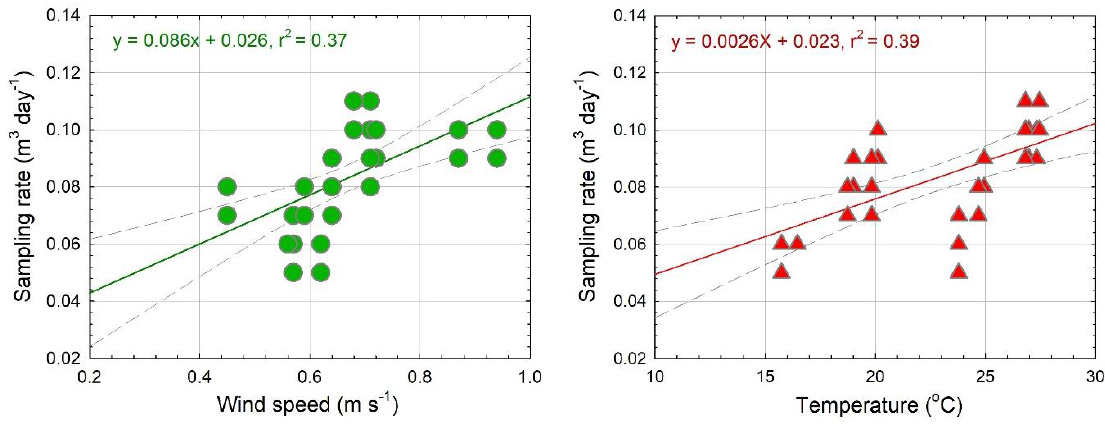
Figure 8. E ff ects of wind speed ( left ) and temperature ( right ) on the experimental Figure 8. Effects of wind speed ( left ) and temperature ( right ) on the experimental SR.